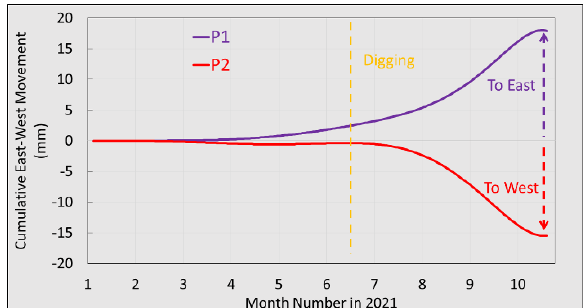
Figure 14. Series of instataneous vertical velocity of P1 (Figure 12). Mining occurred in middle June.